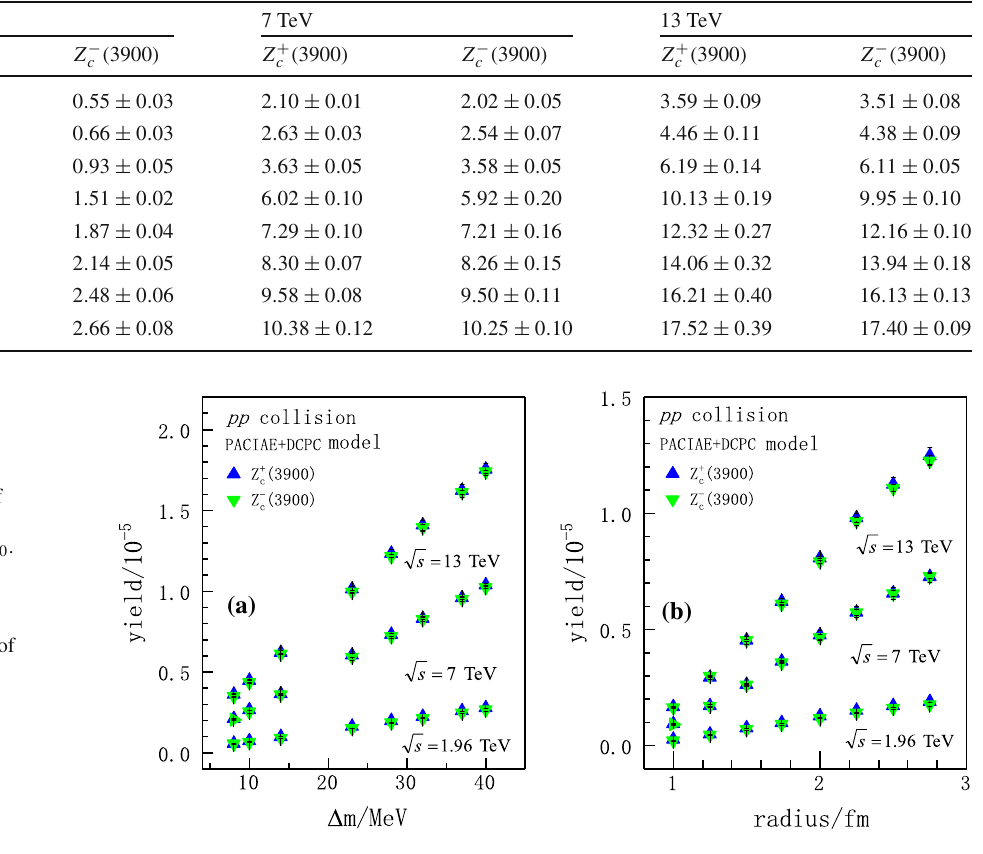
to J /ψπ ± are computed with PACIAE + DCPC model with the radius parameter R 0 fixed to 1.74 fm, based on the Z ± c ( 3900 ) → J /ψπ ± bound state in the decay chain of b hadrons